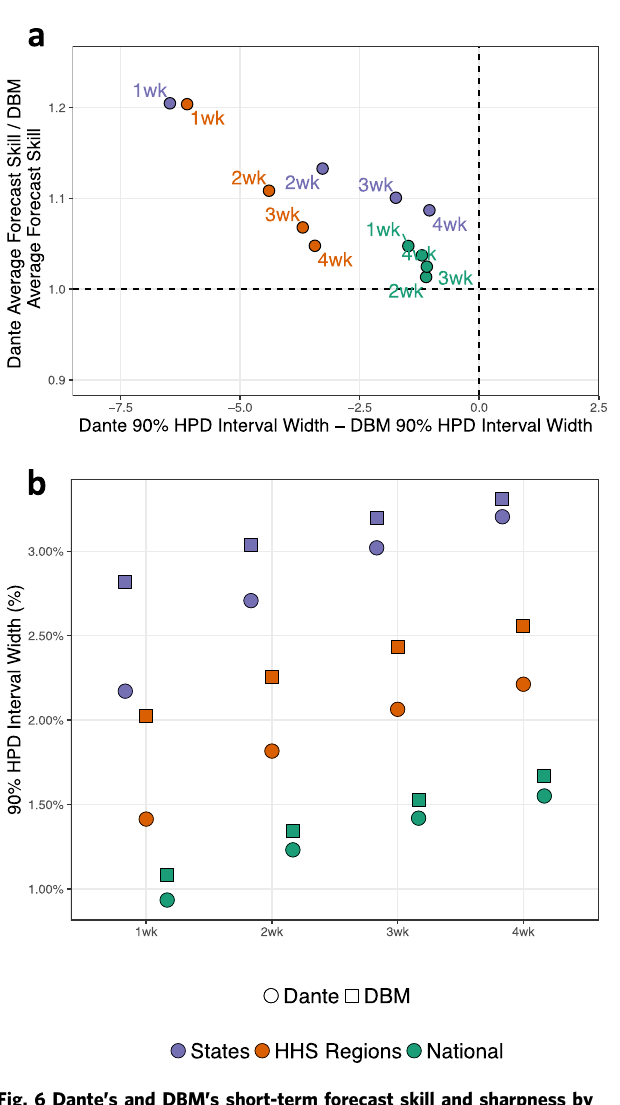
Fig. 6 Dante ’ s and DBM ’ s short-term forecast skill and sharpness by geographic scale. a Ratio of average forecast skills versus difference in 90% highest posterior density (HPD) interval widths for short-term forecasting targets. For all short-term forecasting targets and geographic scales, Dante produced sharper (i.e., smaller 90% HPD interval widths) and higher scoring forecasts than DBM. b Average 90% highest posterior density (HPD) interval widths for the short-term forecasting targets. Both Dante and DBM produce sharper (i.e., smaller 90% HPD interval widths) forecasts for coarser geographic resolutions. For all short-term forecasting targets and geographic scales, Dante produced sharper forecasts than